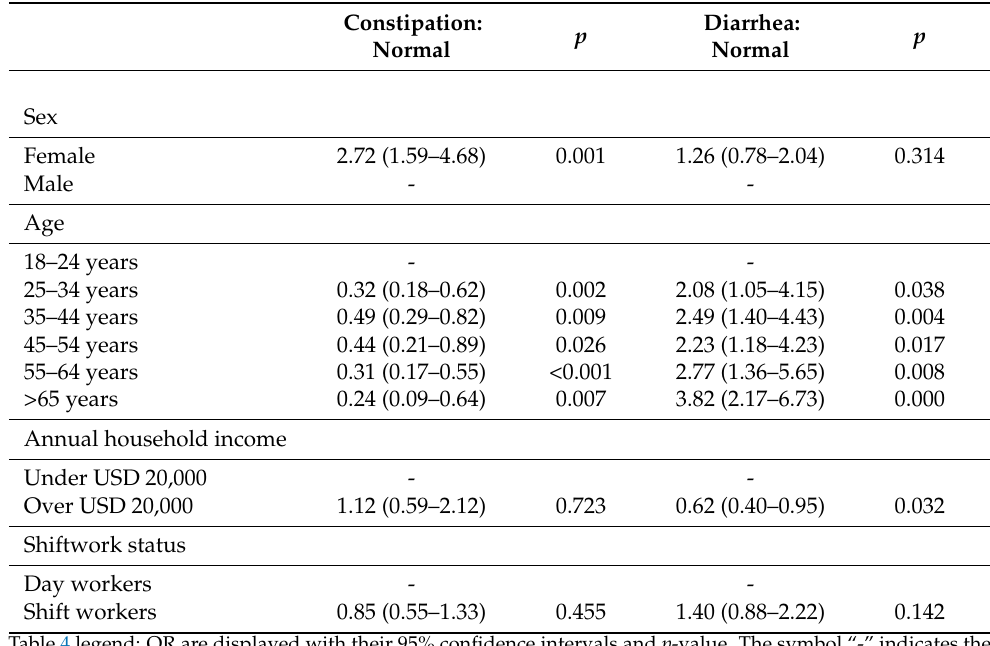
Table 4. Multinomial logistic regression: Estimates of adjusted odd ratios for the stool pattern outcome.